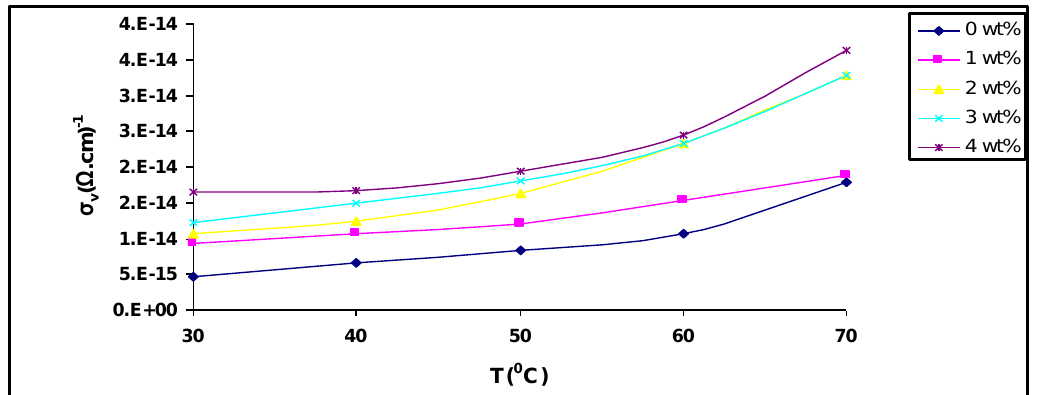
Fig.6 : Electrical volume conductivity of the composite σ